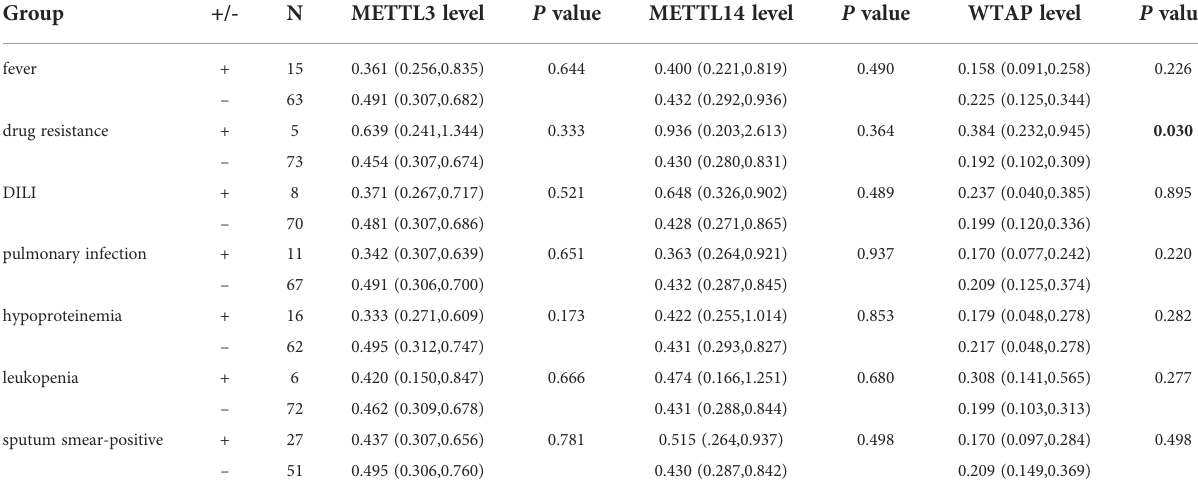
TABLE 4 Association between METTL3, METTL14, and WTAP transcription levels and several clinical features in PTB patients.